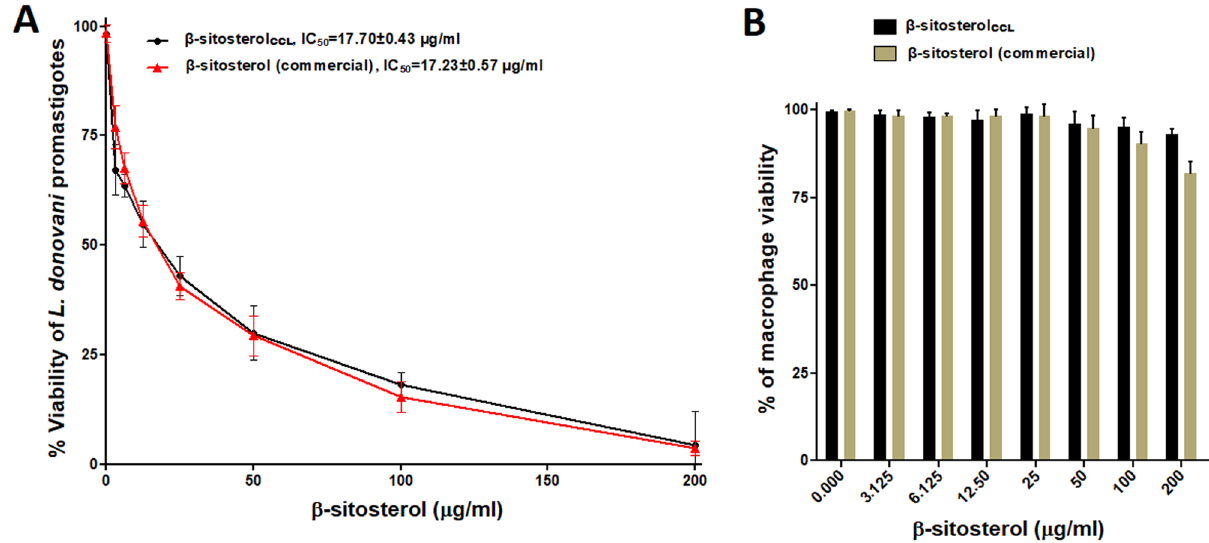
Figure 3. ( A ) Evaluation of antipromastigote activity. L. donovani promastigotes (1 × 10 7 /ml) were treated with commercial β-sitosterol (Abcam, USA) (0–200 µg/ml) for 48 h, and the MTT assay was performed, and the IC 50 was found to be 17.23 ± 0.57 µg/ml, denoted by the red line. β-Sitosterol CCL, as shown by the black line (similar line used in Fig. 1B, IC 50 = 17.7 ± 0.43 µg/ml), was used for comparison with the commercial standard. The results are presented as the mean ± S.E. from three independent experiments. ( B ) Cytotoxicity against murine RAW 264.7 macrophages. The cytotoxic effects of β-sitosterol CCL and commercial β-sitosterol (Abcam, USA) were tested on macrophages (1 × 10 5 /ml) with increasing concentrations (0–200 µg/ml) for 48 h, and an MTT assay was performed. The results expressed herein are from three independent experiments (mean ± to the untreated control. Maximum production of ROS was found at 12 h, after which, ROS generation drasti- cally decreased, reaching close to the level in control cells at 24 h. However, pre-treatment of promastigotes with the ROS quencher NAC (N-acetyl-l-cysteine) restrained the level of ROS generation in β-sitosterol CCL -treated cells to the level in control parasites at the same time points. A comparison of the mean fluorescence intensity (MFI) of the treated and control cells is shown in a bar graph (Fig. 4A), and shifting of the fluorescence inten- sity (FL1-H channel) in β-sitosterol CCL -treated parasites compared to the control is also shown by a histogram (Fig. 4B).